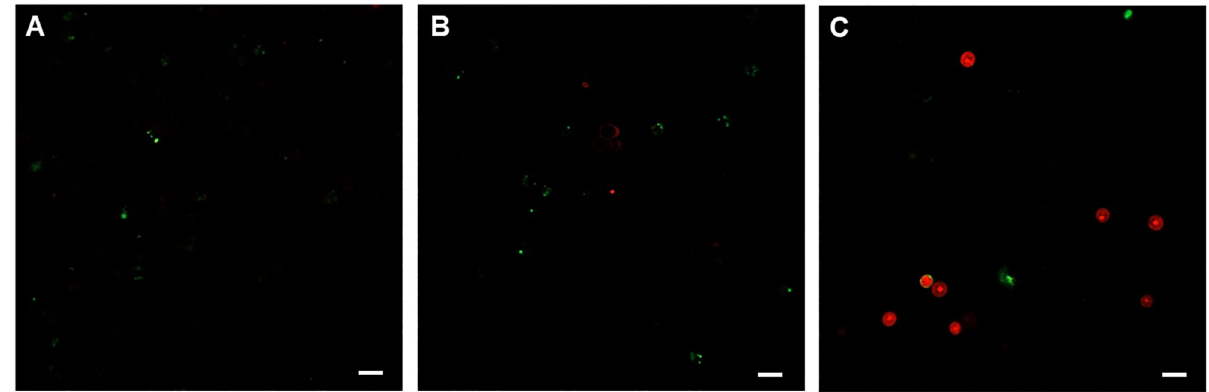
Fig 2. Image-based cytometer analysis to determine cell death after 24 hours of treatment with Torreya nucifera . The process of cell death was evaluated using the Tali ™ Image-based Cytometer using the Tali ™ apoptosis kit. In the groups treated with 25 μ g/mL (B) and 50 μ g/mL (C) of T . nucifera , the green and red fluorescence indicating apoptosis and necrosis, respectively were clearly observed unlike that in the control group (A). The scale bar represents 20 μ m.